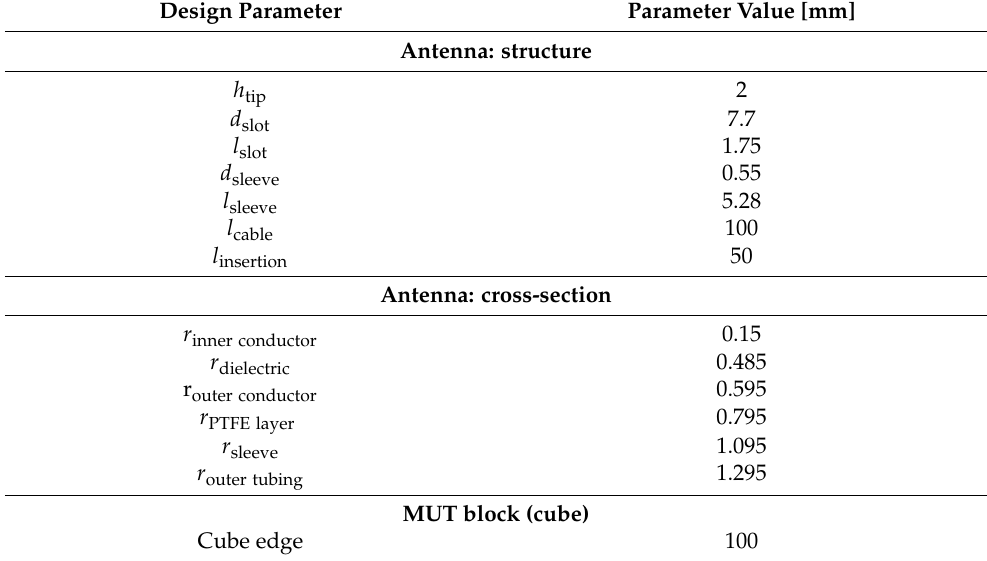
Figure 1. ( a ) Antenna design transversal view; ( b ) Cross section of the coaxial cable used for the design; ( c ) Geometry of the simulations. Metal parts are represented in yellow, while the insulation materials are represented in blue. Table 1. Design parameter overview.